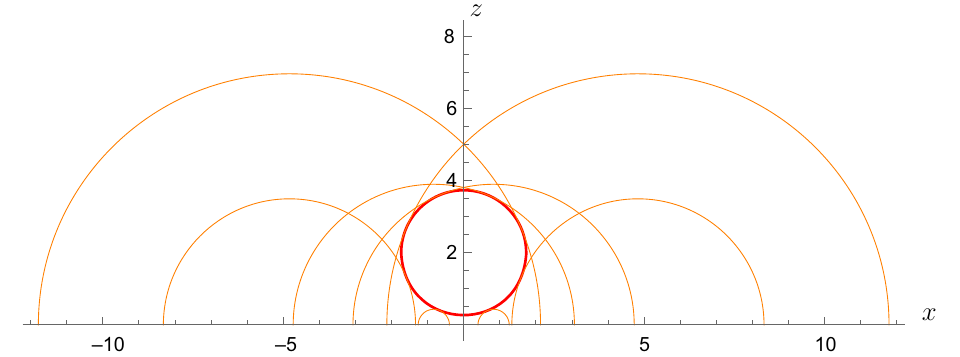
meaning that the radius of the circle (in both global and Poincaré coor- √ dinates) is R =